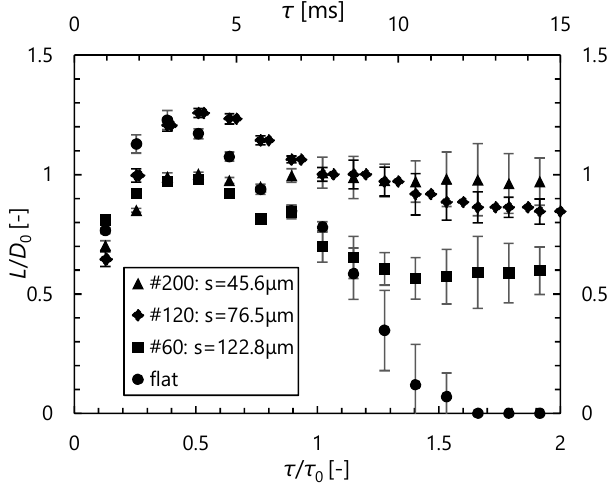
Figure 10. Contact length normalized by drop diameter corresponding to elapsed time normalized by period τ 0 = D 0 / U 0 . Surface temperature is T s ≈ 335 ◦